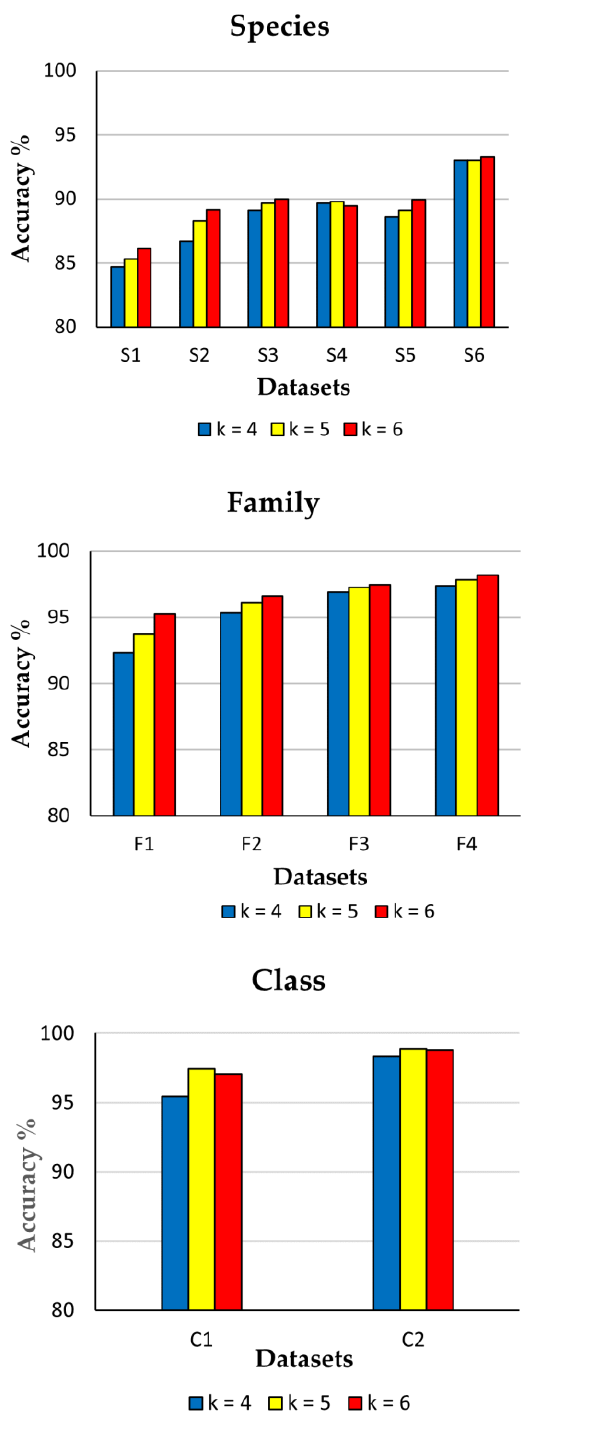
Figure 5. Average accuracy % of CNN for different datasets with varying k -mer sizes at all taxonomic levels.